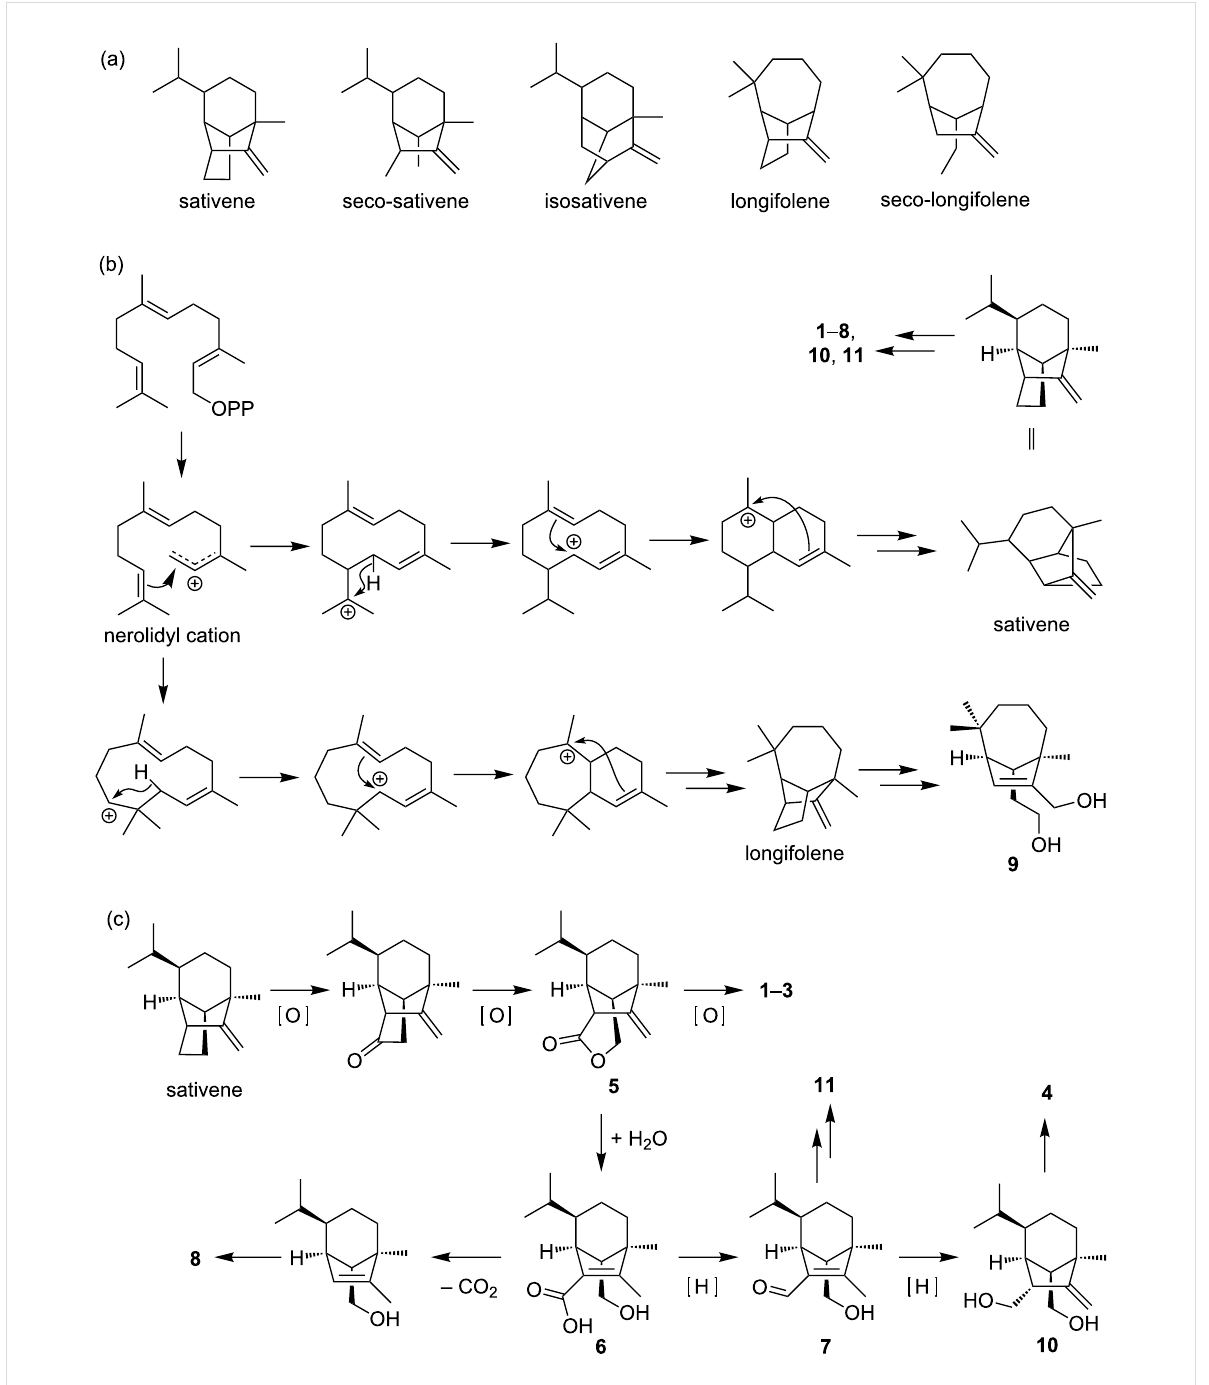
Figure 5: Relationship of sesquiterpenoids isolated in this study. A) Different groups of sativene/longifolene-type sesquiterpenoid scaffolds; B) The branched pathways to sativene- and longifolene-type sesquiterpenoids. C) Detailed proposed pathways to the sativene-derived sesquiterpenoids from this